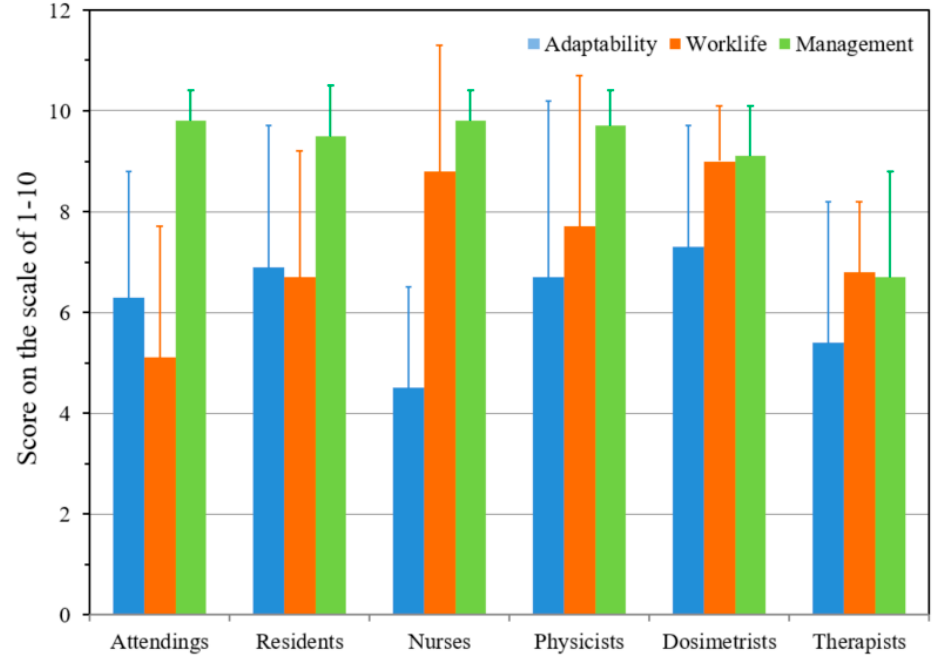
Figure 2. Analysis of the three common questions for all staff members. Please note the adaptability is variable in each group depending on the contacts with patients.